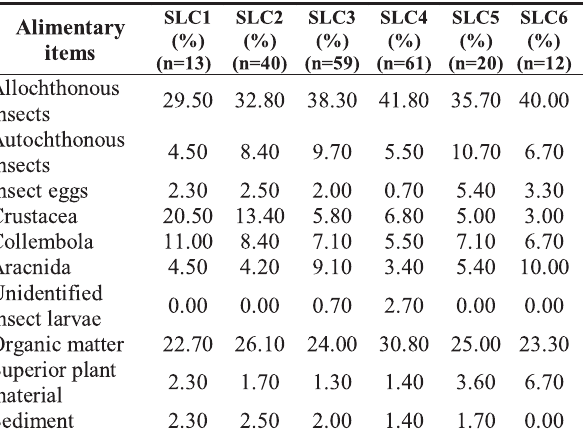
Table 3. Percent composition of dietary items found in stomachs of Mimagoniates rheocharis for standard length